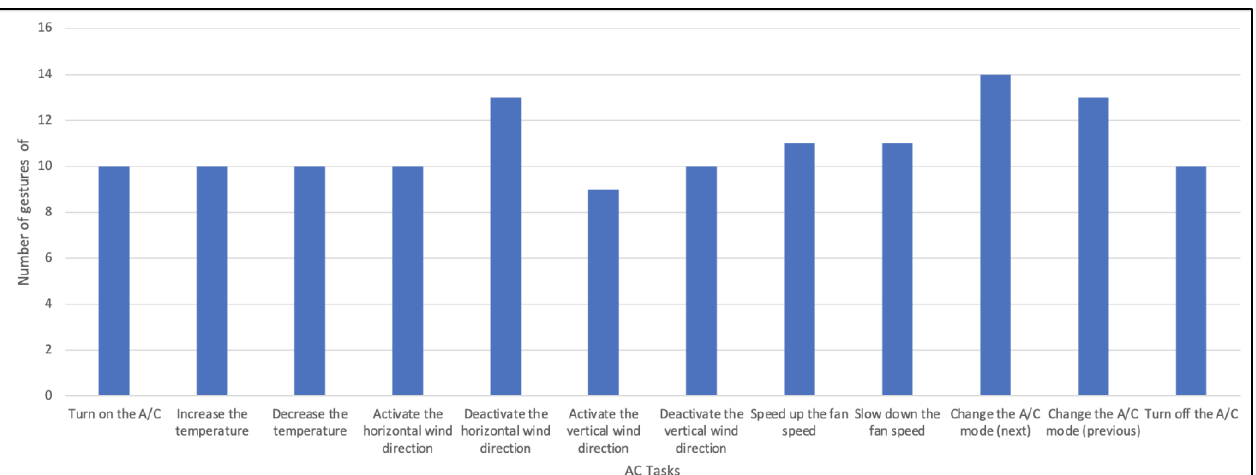
Figure 5. Gesture taxonomy breakdown using HomeG.